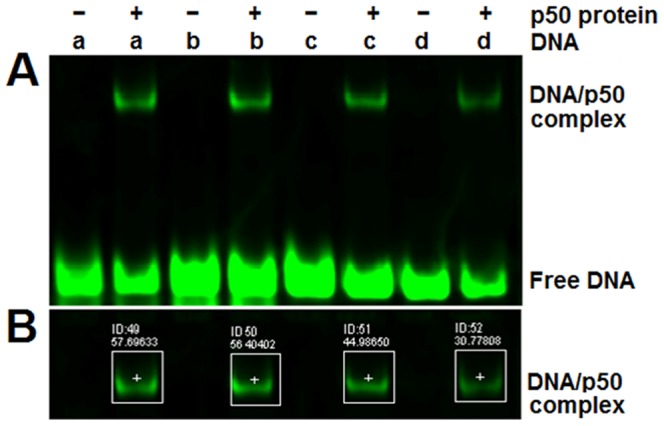
Detection of the DNA-binding affinities of the NF-κB p50 homodimer to four sequences with NIRF-EMSA.A, A representative image of the NIRF-EMSA detections. B, The quantified signal intensities of the shifted bands (labeled as DNA/p50 complex in Image A). a, GGGGATTCCC; b, GGGATCTCCC; c, GGGATACCCC; d, GGGAGGCCCC.